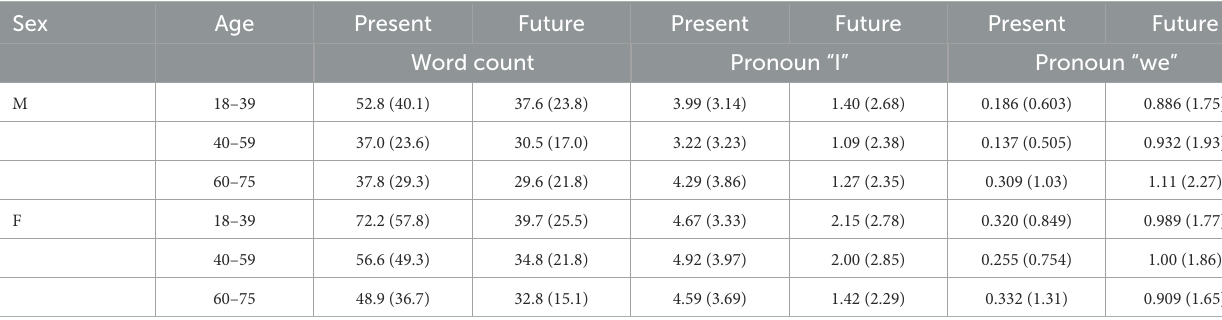
TABLE 3 Descriptive statistics for linguistic features.